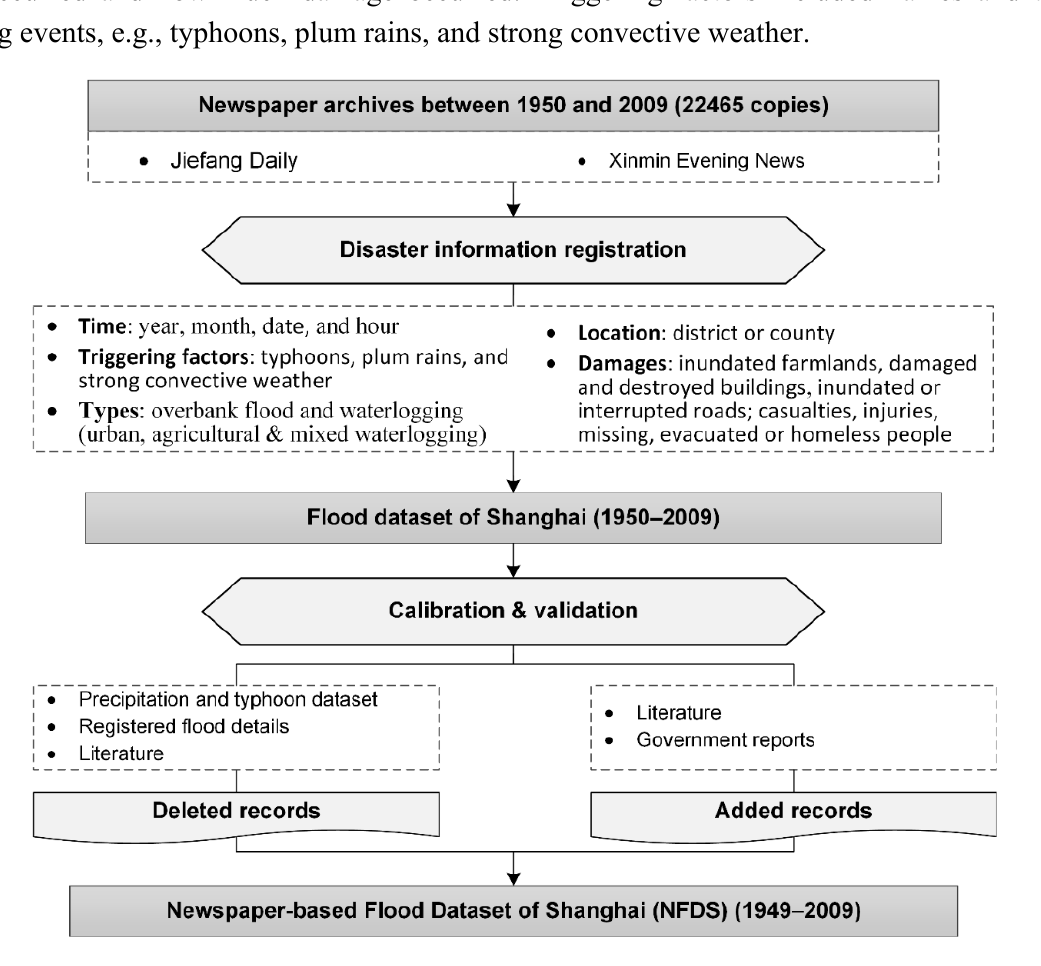
Figure 2. Methodology of developing NFDS